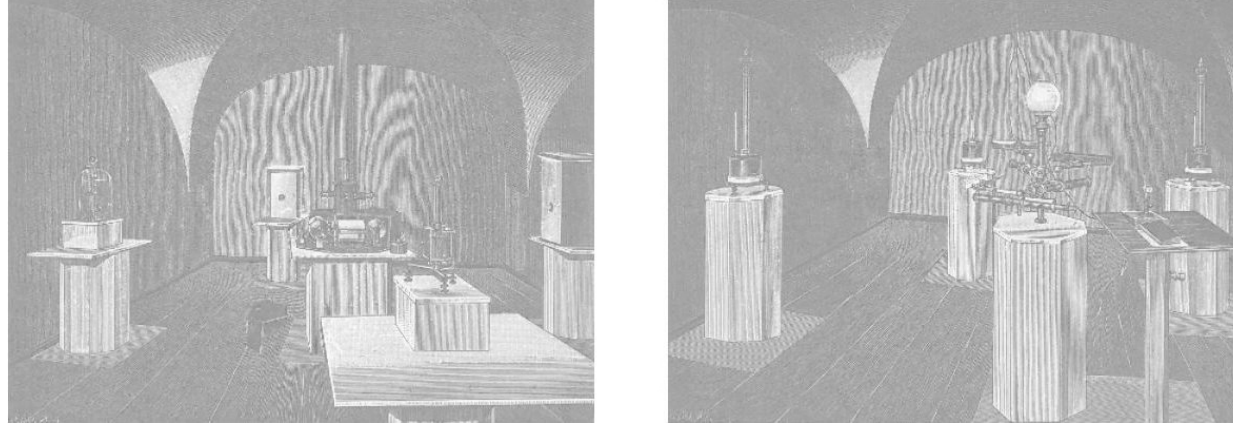
Hist. Geo Space Sci., 14, 23–31, 2023